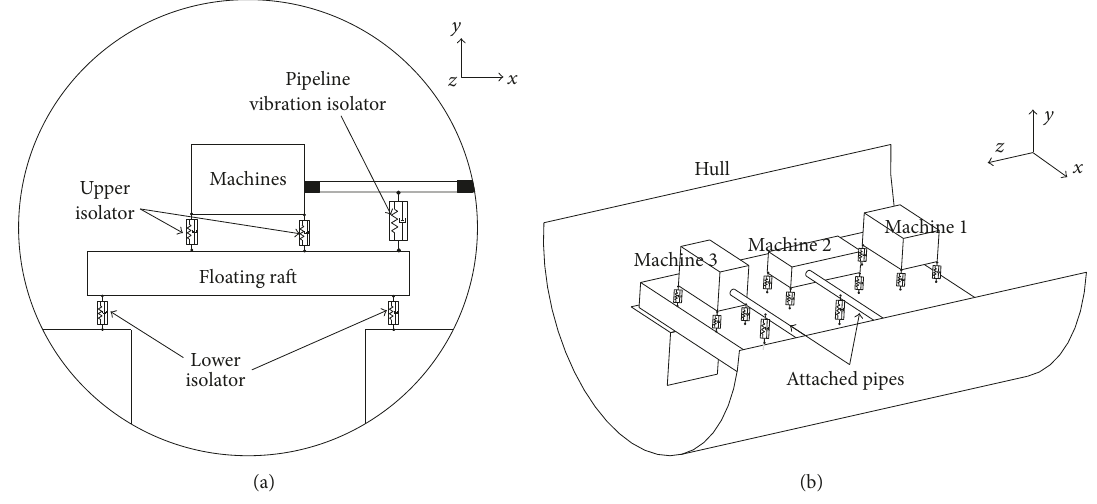
Figure 3: Sketch of the floating raft system: (a) front view, (b) sectional